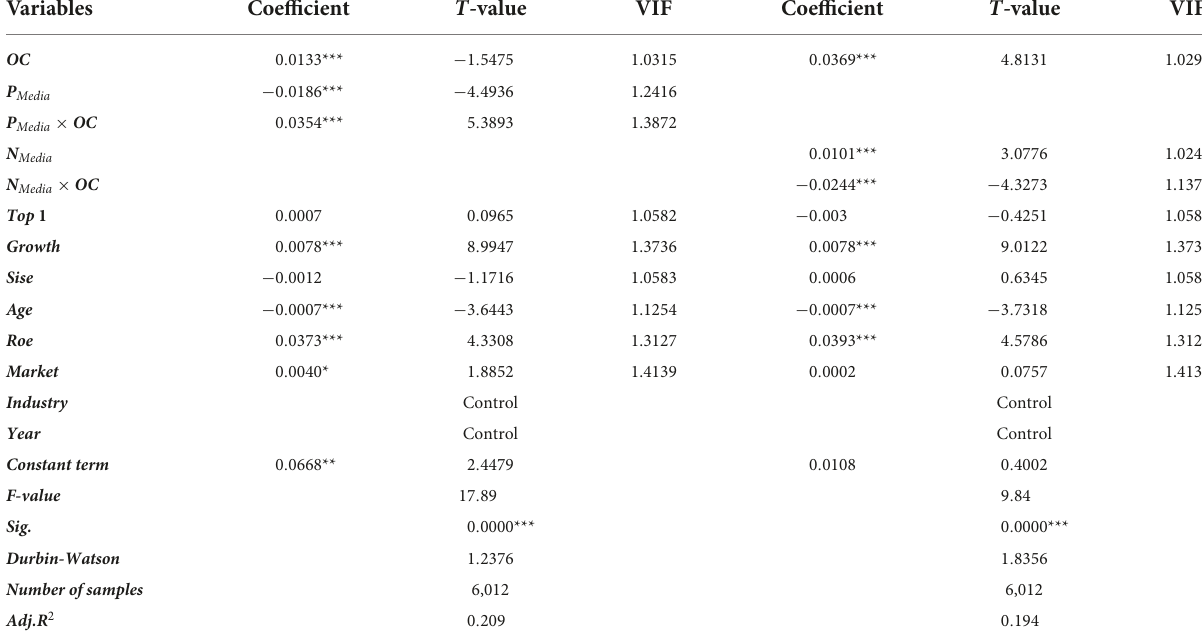
TABLE 5 Regression results of the moderating effect of positive and negative media